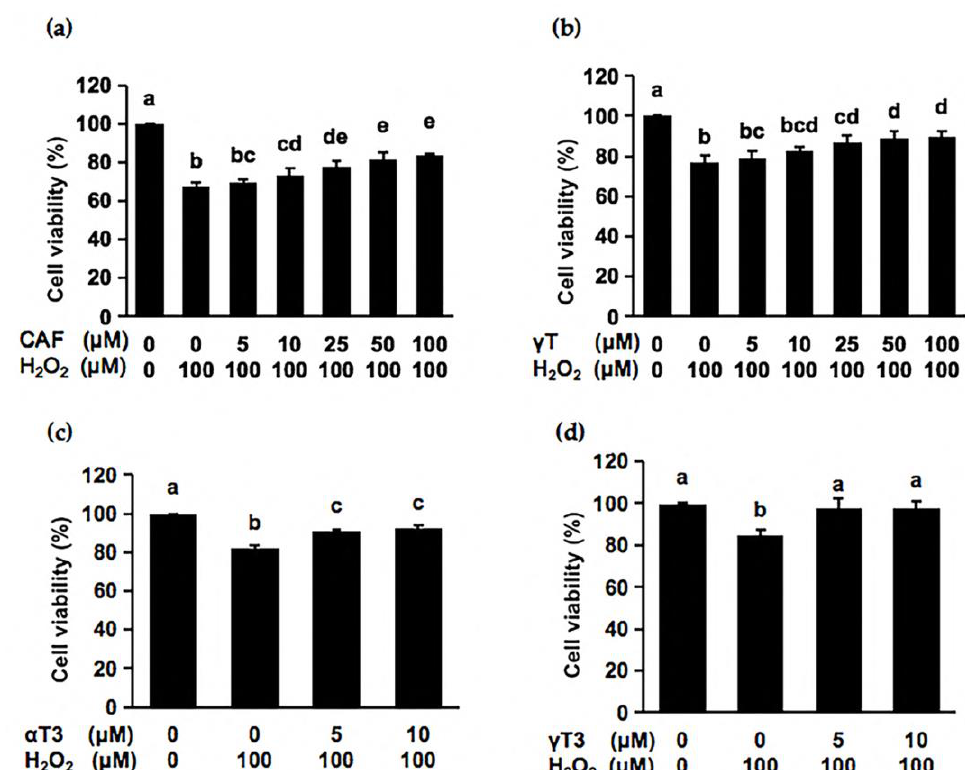
Figure 1. Protective effect of the main phytochemicals of brown rice in Hepa1c1c7 cells. Hepa1c1c7 cells were preincubated with cycloartenyl ferulate (CAF) ( a ), γ -tocopherol ( γ T) ( b ), α -tocotrienol ( α T3) ( c ) or γ -tocotrienol ( γ T3) ( d ) at the indicated concentrations for 24 h, then treated with hydrogen peroxide (100 µ M) for 6 h. Cytotoxicity was evaluated using a MTT assay. Values were means ± SD of three independent experiments. The different letters above the bars indicated significant differences among the treatments for each condition ( p < 0.05).